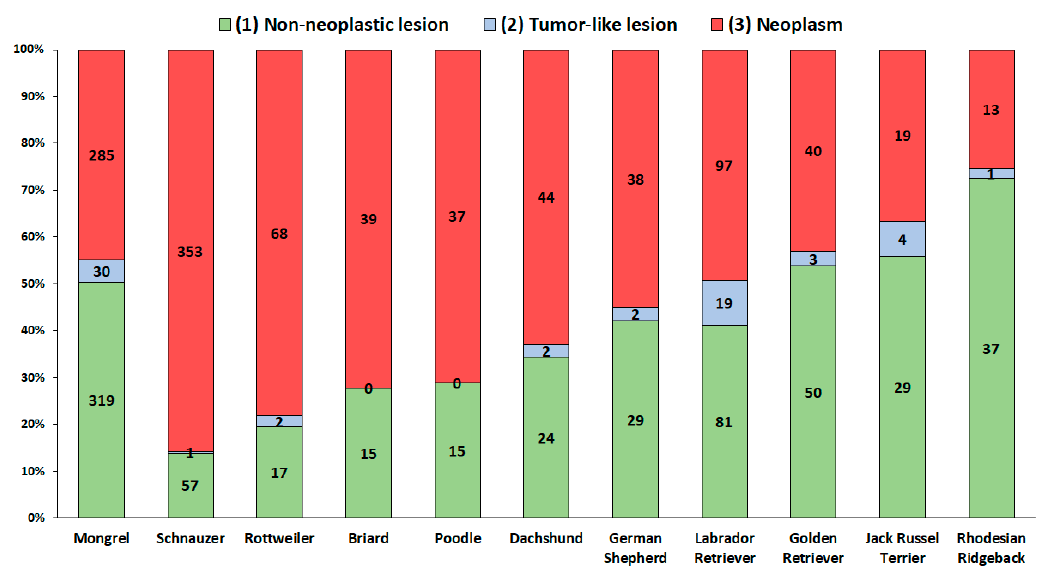
Figure 2. Distribution of non-neoplastic lesions, tumor-like lesions, and neoplasms in digital sam- ples of the most common breeds (more than 50 dogs per